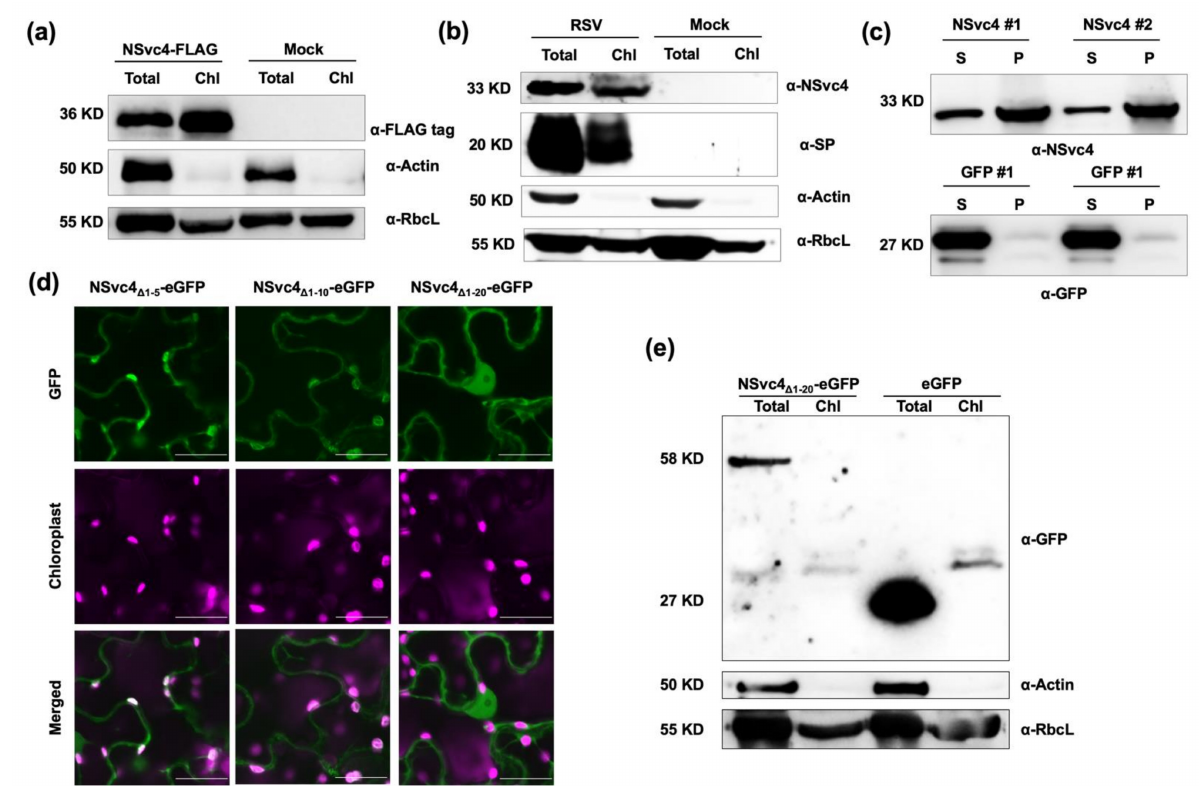
Figure 1. N-terminal 20 AAs are indispensable for NSvc4 to localize to chloroplasts. ( a ) Western blotting of total and chloroplast protein of N. benthamiana leaves transiently expressing NSvc4-FLAG and wild-type plants. Total, total protein. Chl, protein from the isolated chloroplasts fraction. Actin (cytoplasm marker). RbcL, RuBisco large subunit (chloroplast marker). ( b ) Western blotting of total and chloroplast protein from wild-type and RSV-infected N. benthamiana leaves. SP, disease-specific protein of RSV (RSV marker in the chloroplast). ( c ) N. benthamiana chloroplasts incubated with NSvc4 and eGFP were subjected to Western blotting. S, supernatant. P, pellet (intact chloroplast fraction). ( d ) Confocal images of N. benthamiana leaves infiltrated with agrobacteria carrying the constructs